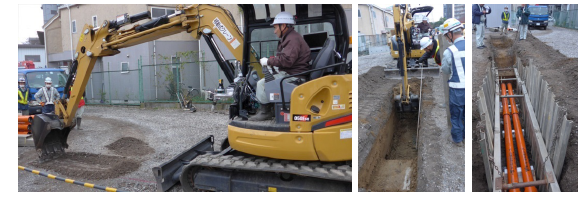
Figure 8. Simulated construction environment